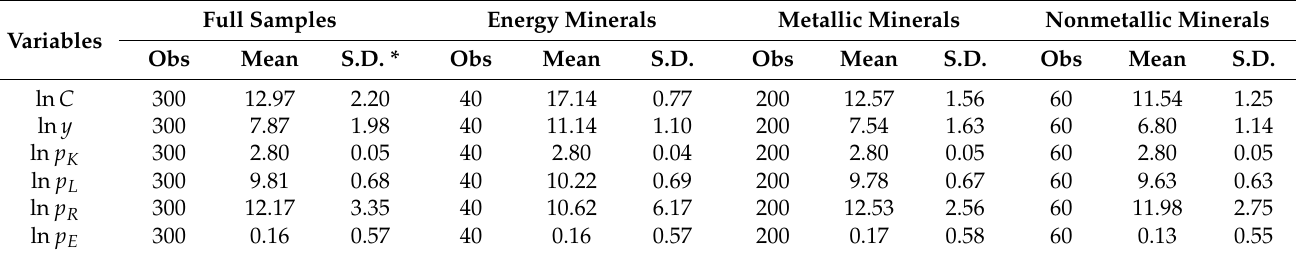
Table 3. Descriptive statistics.